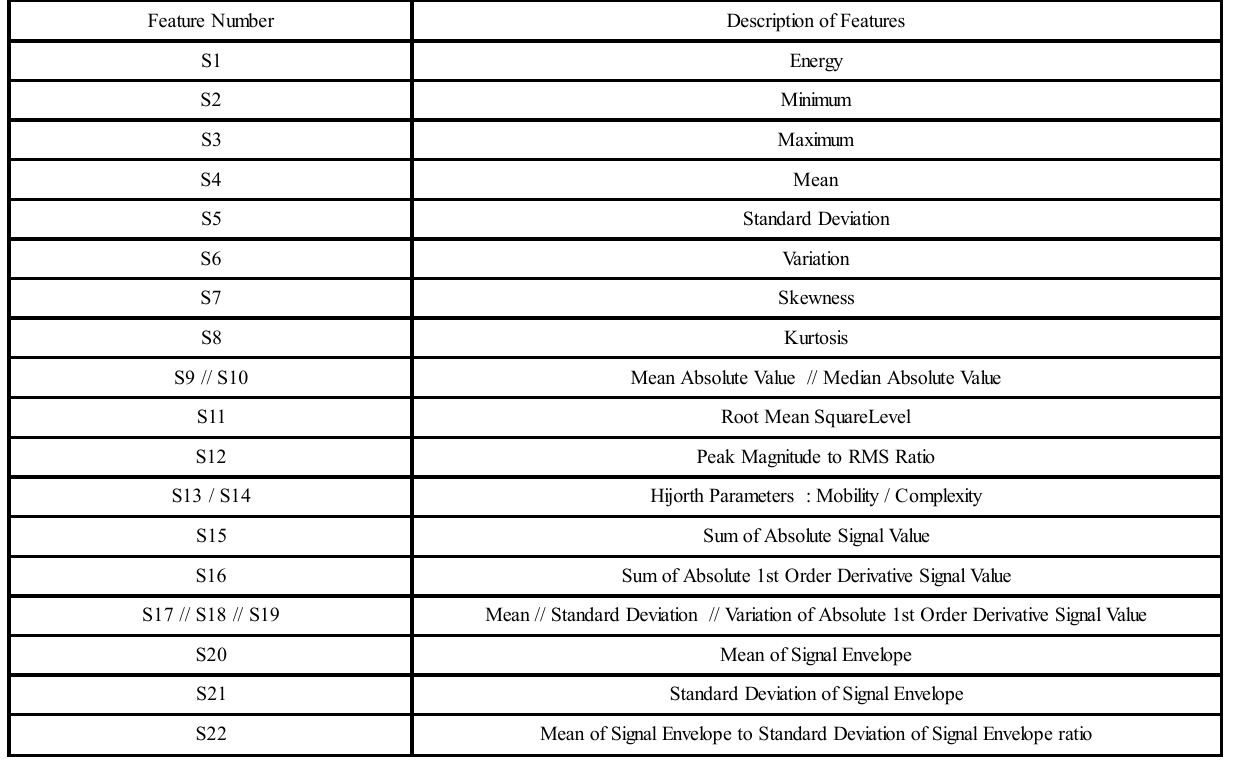
TABLE 1. SET-1: CLASSIC